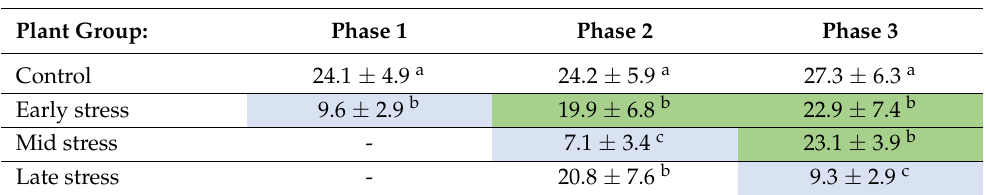
Table 1. Soil water content (Volumetric %). Average values ( ± STD) for measurements starting from day 3 are reported. Average of 2 daily measurements performed starting 9.15 a.m. and 2.45 p.m., each time on 9 plants/treatment. Keys: ‘Control’ = no treatment/full irrigation; ‘Early Stress’: WD